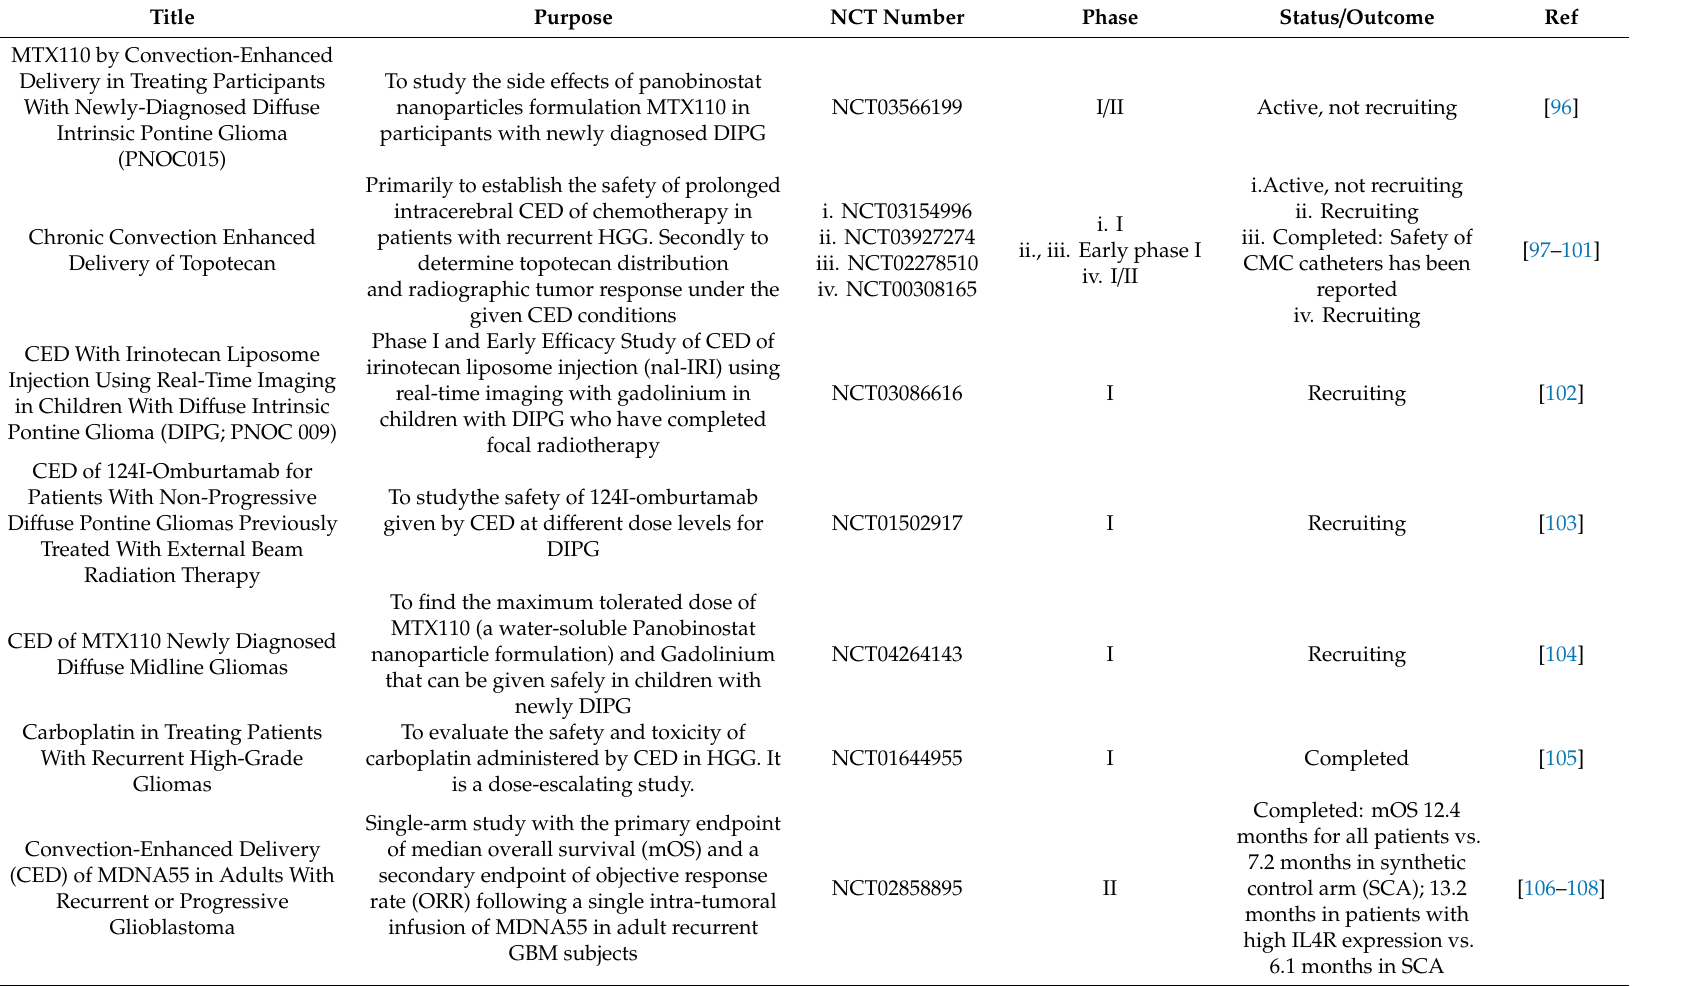
Table 3. Summary of clinical trials with convection-enhanced delivery (CED) for brain tumors from the clinicaltrials.gov database (accessed on 20 September